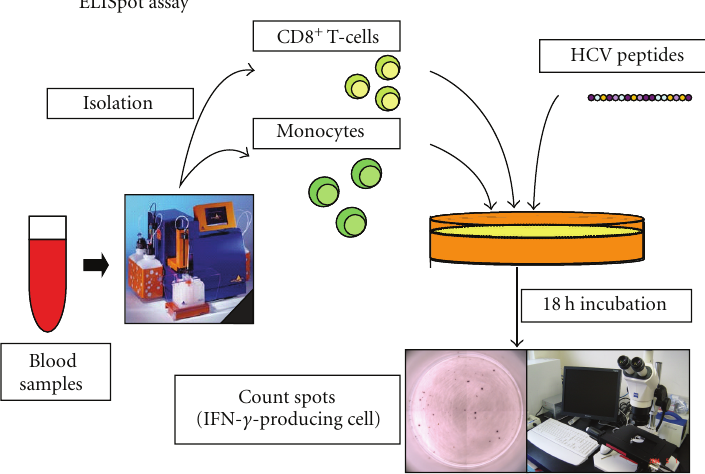
Figure 4: The procedure of enzyme-linked immuno-spot (ELISpot) assay. To detect CTL responses against HCV, we performed IFN- γ - based ELISpot assay. CD8 + cells and monocytes were separated from peripheral blood samples by magnetic beads (MACS system; Miltenyi Biotec, Bergisch Gladbach, Germany) and used as e ff ector cells and antigen-presenting cells, respectively. These cells with synthetic HCV peptides were incubated for 18h at 37 ◦ C in 5% CO 2 atmosphere. Using an ELISpot reader (KS ELISPOT compact; Carl Zeiss, Oberkochen, Germany), the number of spot-forming cells (SFCs) per well was